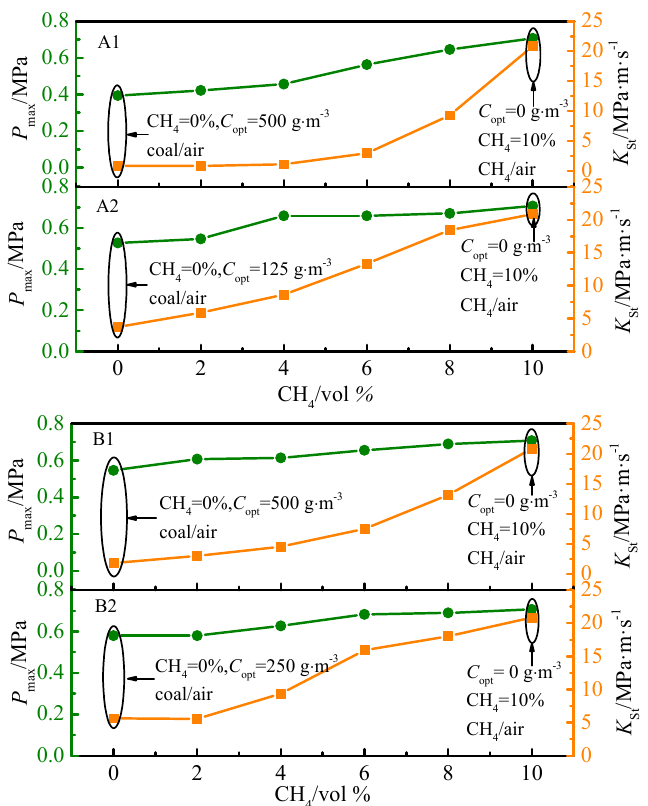
Figure 3. Diagram of maximum explosion pressure and exponential change of hybrid mixture of coal dust and gas.